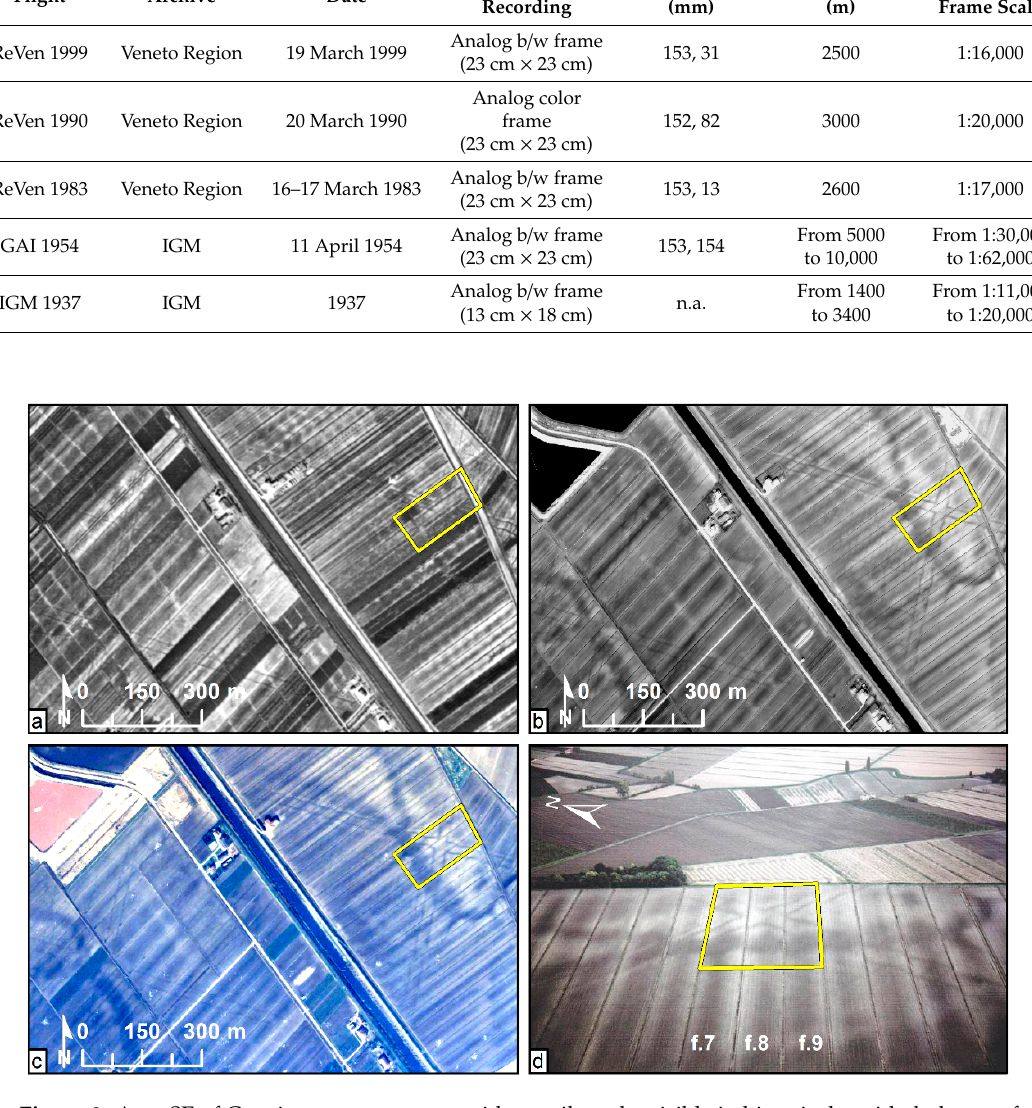
Figure 3. Area SE of Ceggia: zoom on some evident soil marks visible in historical zenithal photos of different years and a recent oblique photo. In yellow, the area subject to geophysical investigations, core drilling, and cleaning of the exposed sections. ( a ) Photo GAI 1954. ( b ) Photo ReVen 1983. ( c ) Photo ReVen 1990. ( d ) Oblique photo [5].